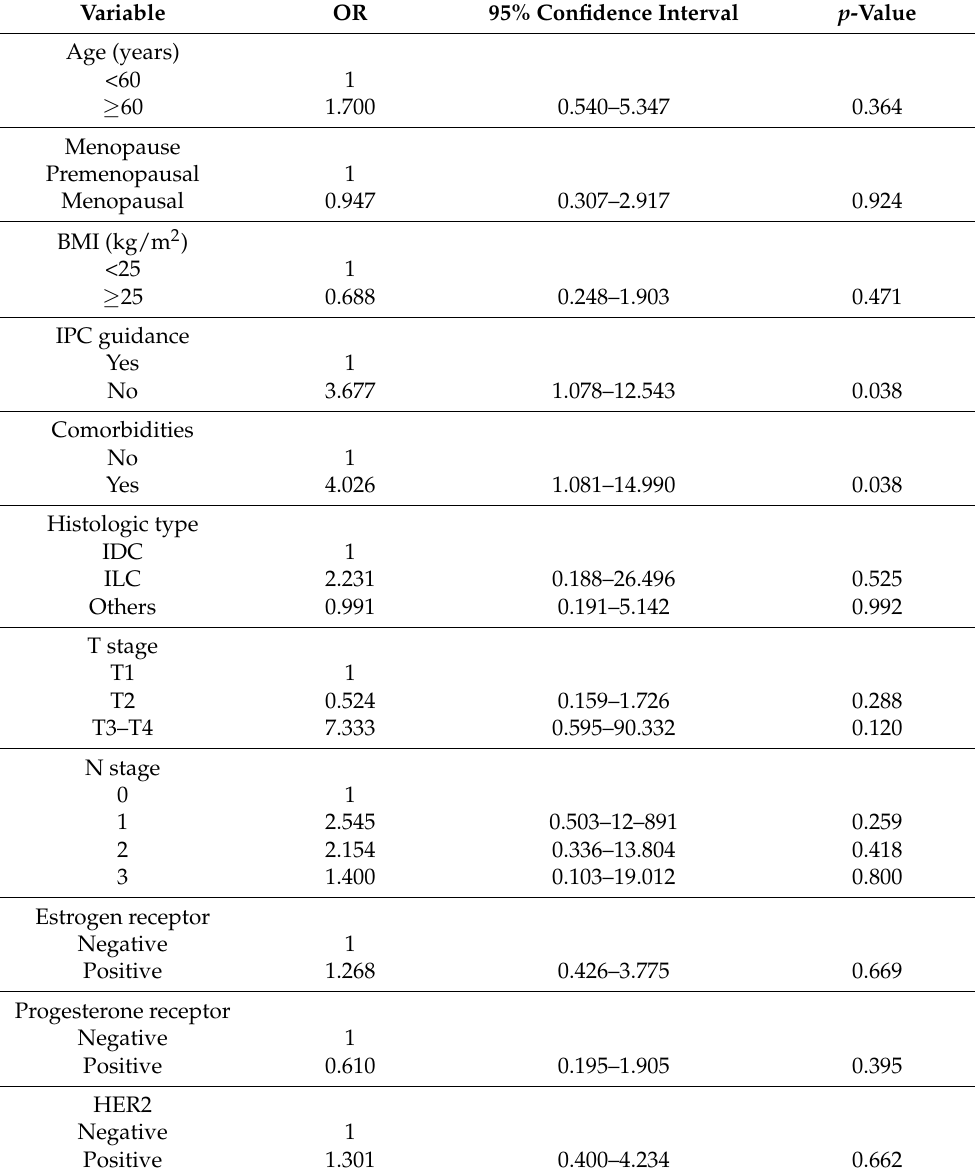
Table 3. Odds of febrile neutropenia according to logistic regression